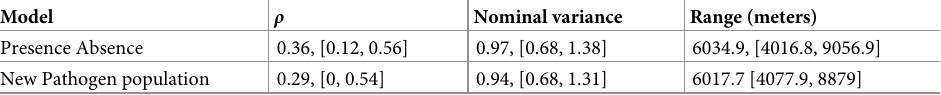
Table 2. Posterior medians and 95% credibility intervals for the hyperparameters of the statistical model, where ρ describes the 1st order autocorrelation, nominal variance and range describes the spatial random field, where nominal variance describes the overall variance of the field and range corresponds to the distance after which the spatial autocorrelation is estimated to become smaller than 0.1, when the Matern covariance structure is